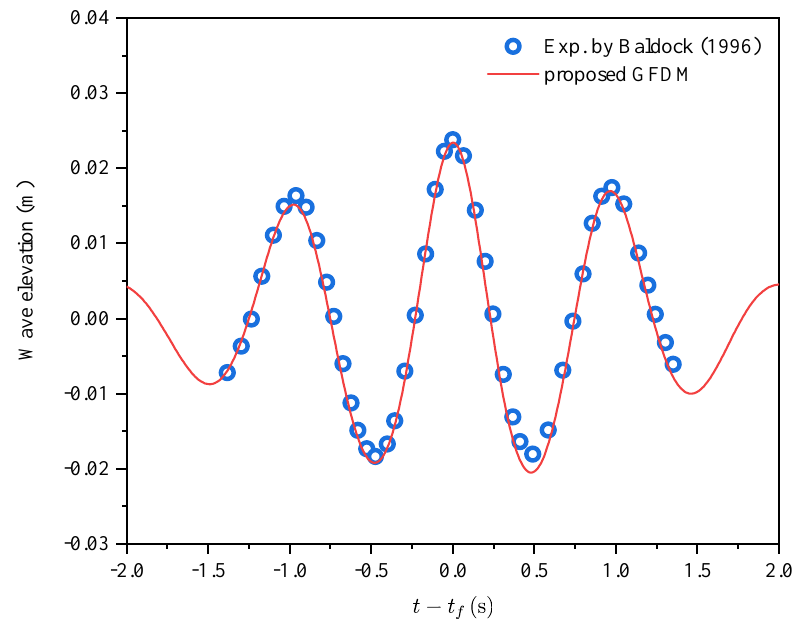
Figure 9. Comparison of free-surface elevation at the focusing location between numerical results and experimental